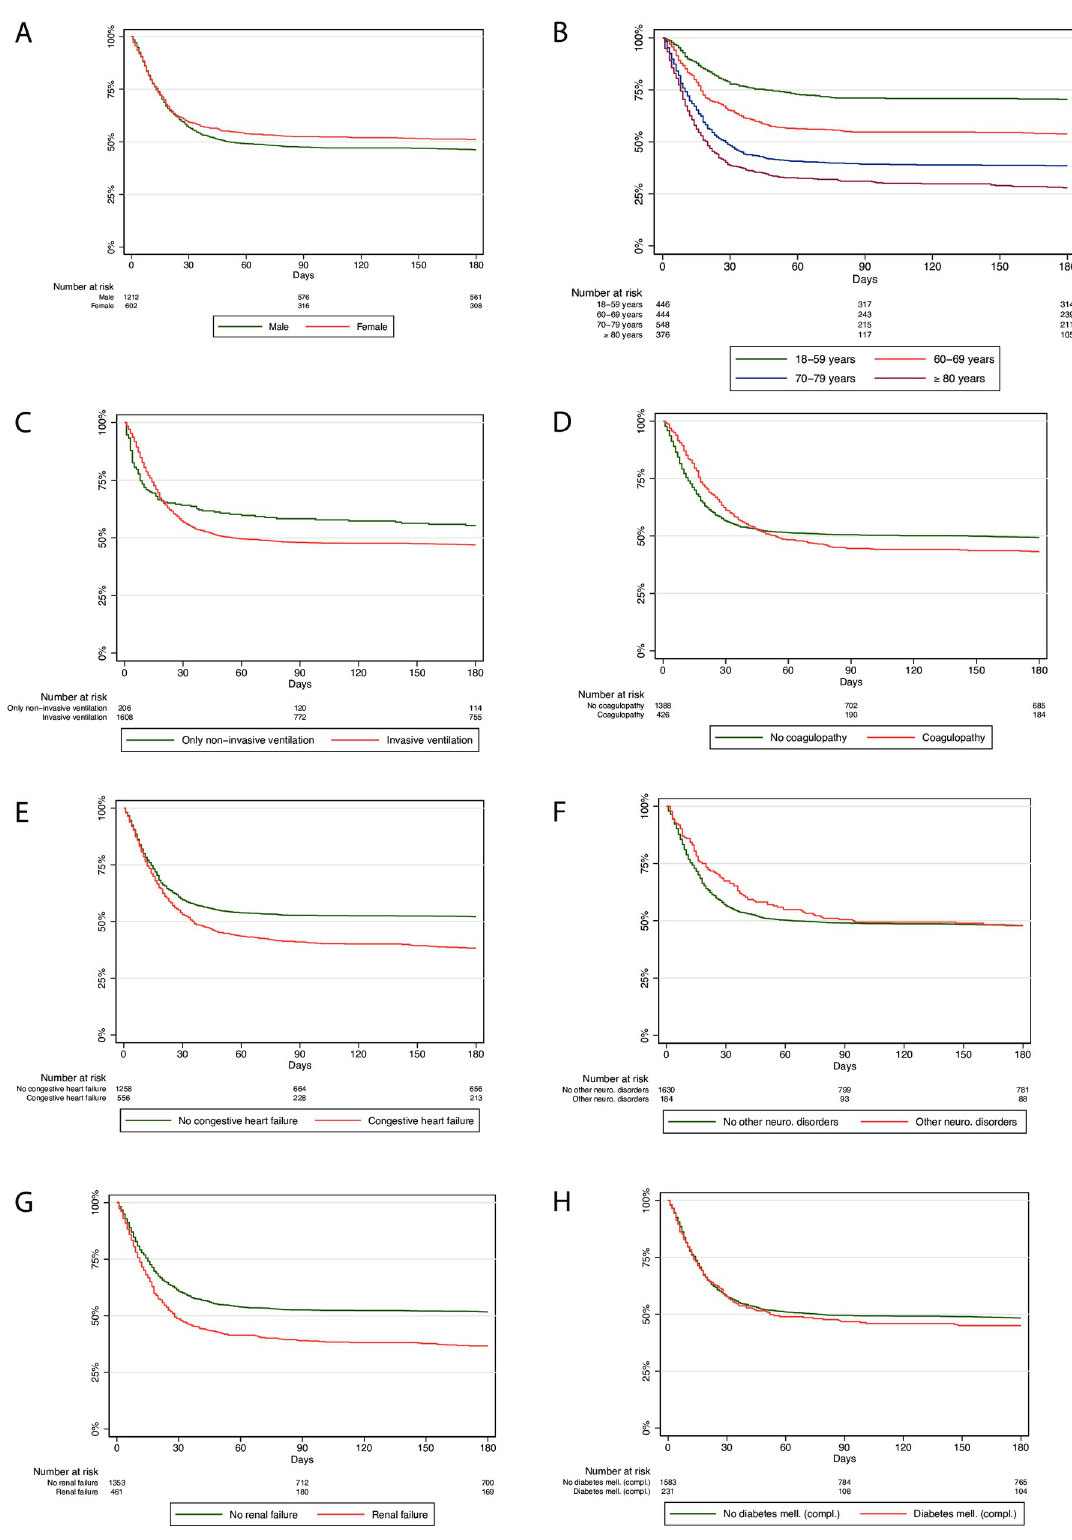
Fig 3. Kaplan-Meier survival curves of all hospitalized COVID-19 patients on mechanical ventilation followed for 180 days after hospital admission.